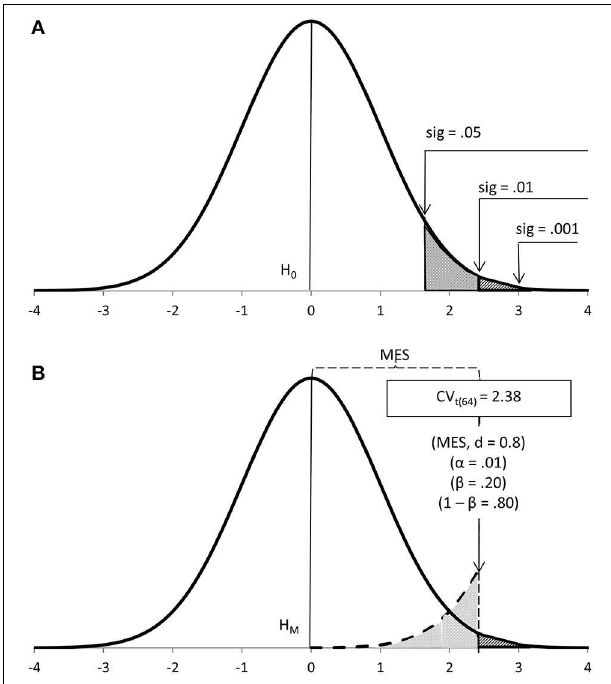
FIGURE 1 | Fisher’s (A) and Neyman-Pearson’s (B) approaches to data testing mapped onto a t -test distribution with 64 degrees of freedom.